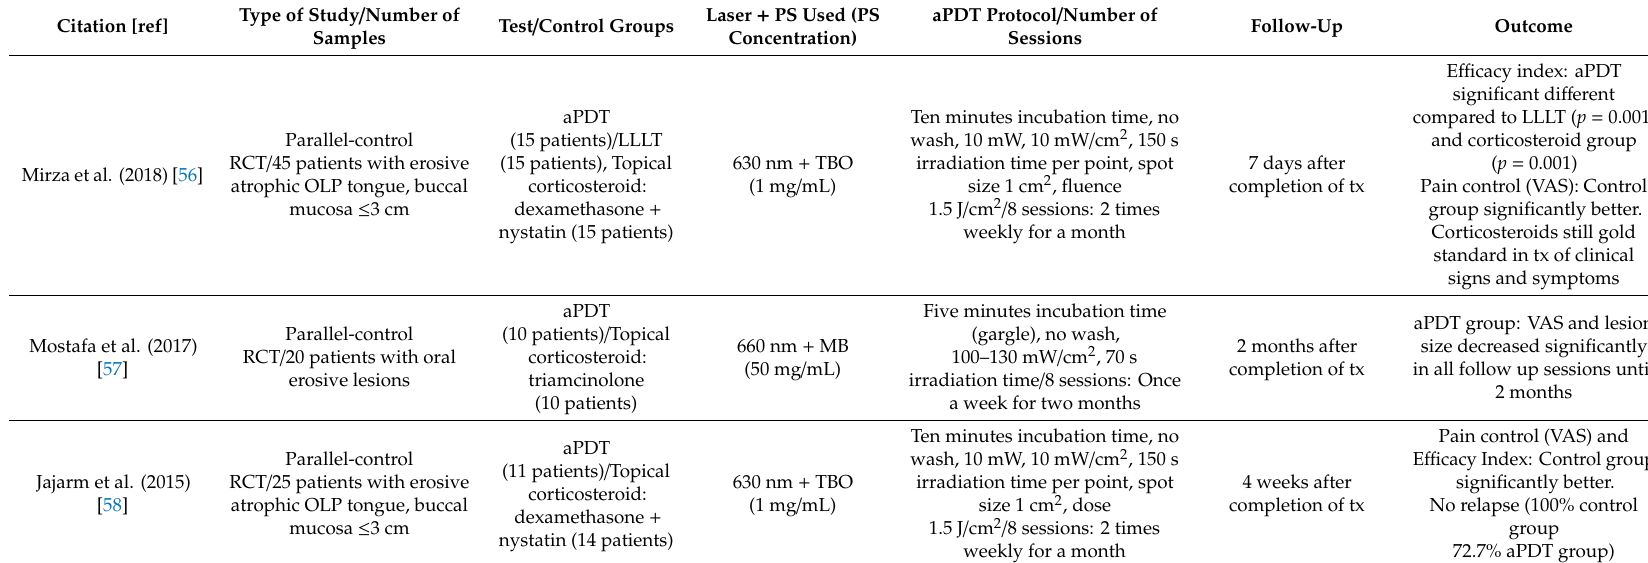
Table 6. Studies with aPDT in Oral Lichen Planus.